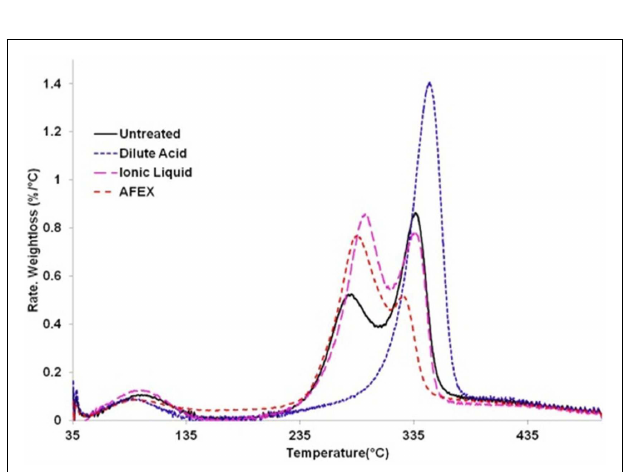
FIGURE 4 | Differential thermo-gravimetric curves of untreated and pretreated corn stover samples